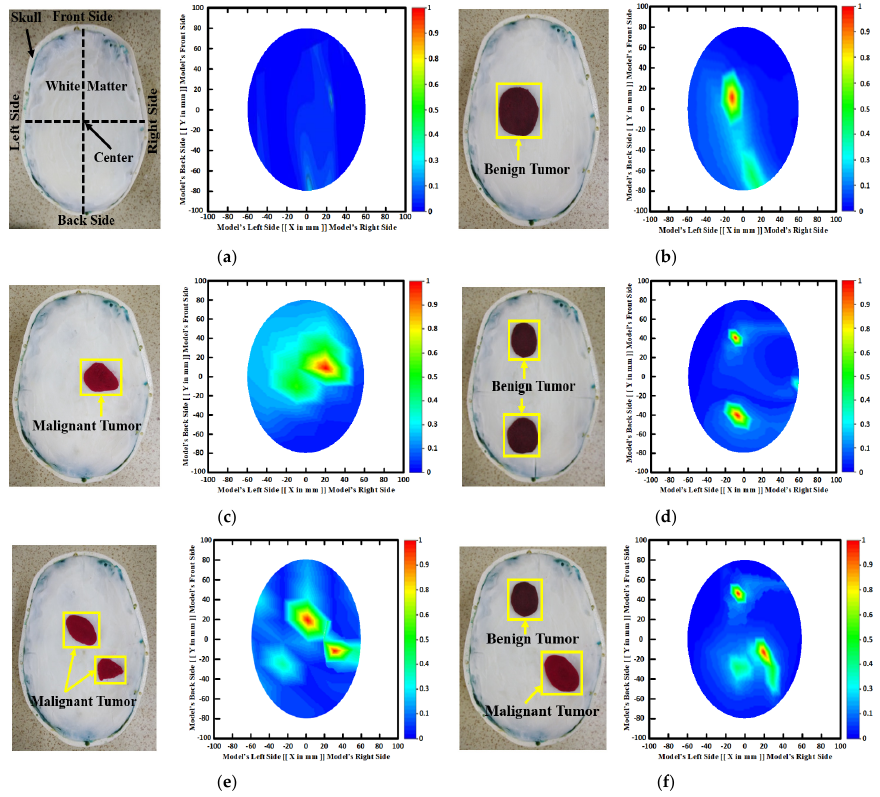
Figure 3. Samples of formulated tissue-imitating head phantom models with RMB images: ( a ) Non- tumor (NT), ( b ) Single BT image, ( c ) Single MT image, ( d ) Two BBT image, ( e ) Two MMT image, ( f ) Single benign and single malignant tumor (BMT).